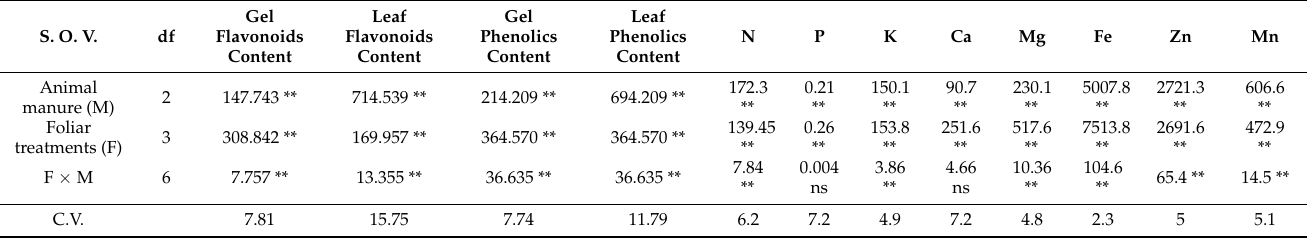
ns: non-significant; ** Significant difference at p ≤ 1%. S. O. V., df, and C. V. refer to the source of variation, degree of freedom, and coefficient of variation,